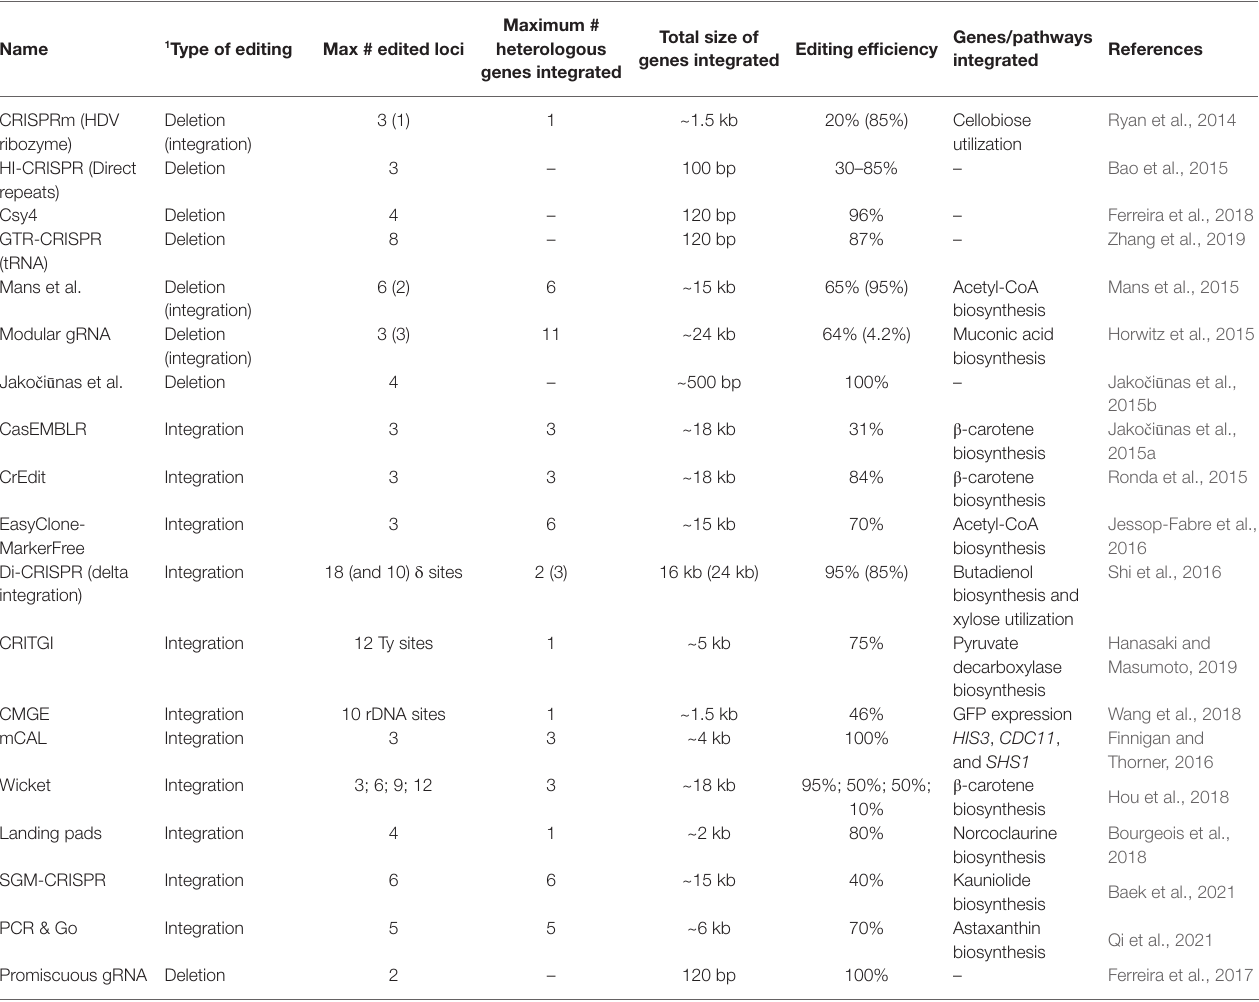
TABLE 1 | Summary of studies that were reviewed in this